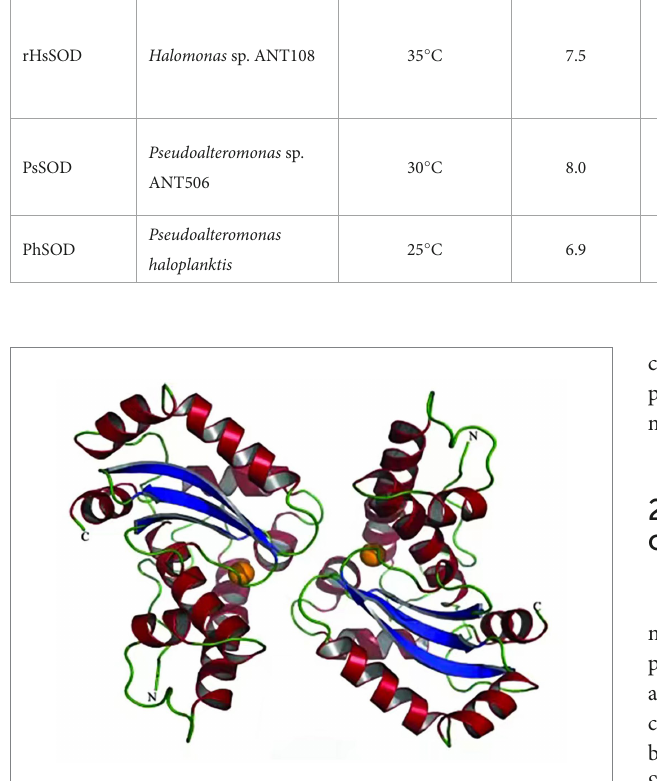
FIGURE 2 Superoxide dismutase from Aliivibrio salmonicida structure (Pedersen et al.,